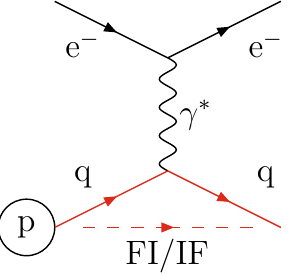
Fig. 2 Deeply inelastic scattering: an incoming electron scatters one of the quark within the incoming proton. The dashed line represents the colour line stretching between the two dipole